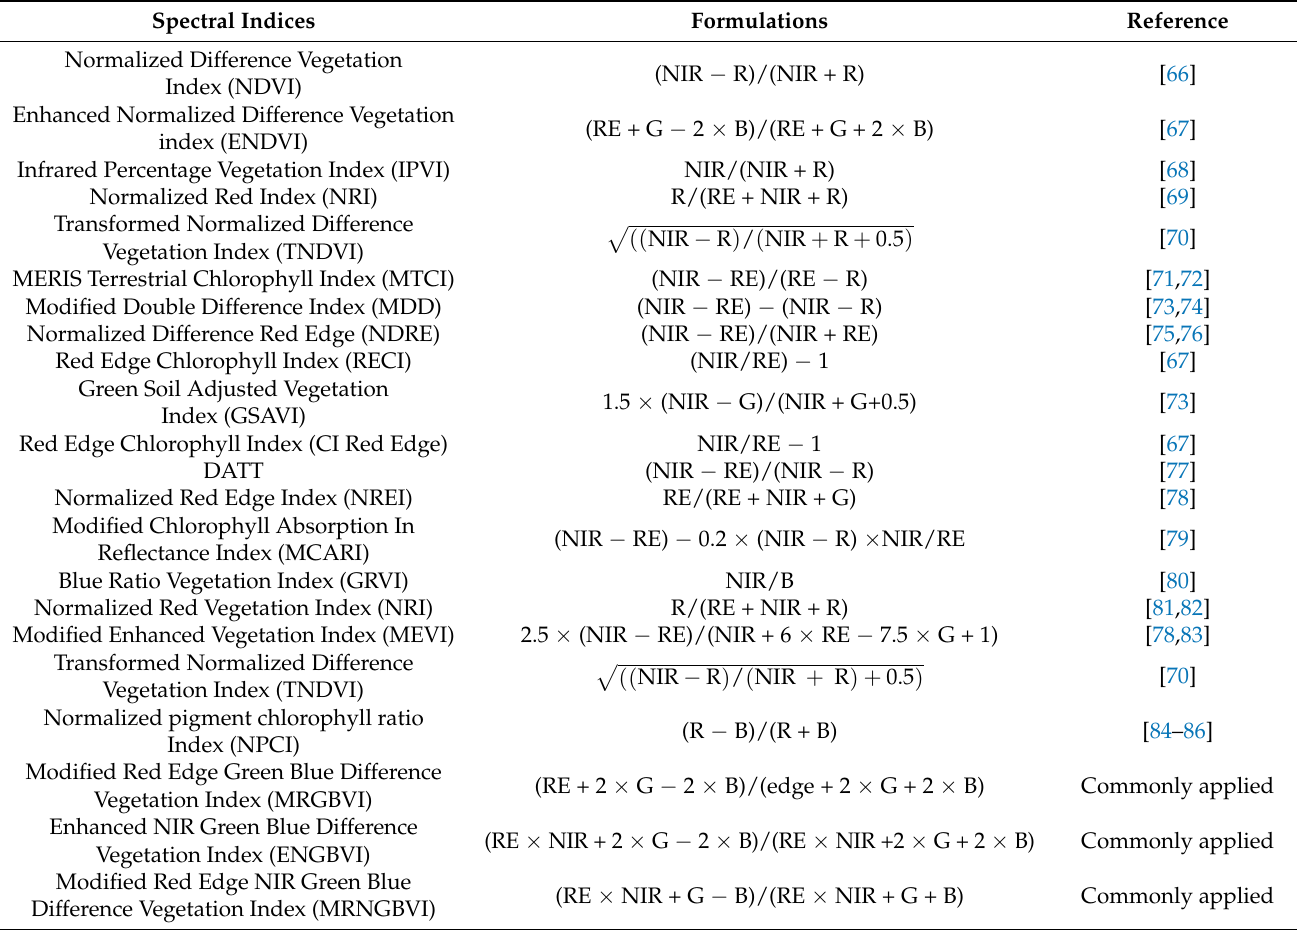
Table 2. The multi-spectral indices evaluated in this study. B, G, R, RE, and NIR each represent the blue, green, red, red edge, and near infrared band in reflectance. The first column indicates the name of spectral indices, the second column is the corresponding definition of the spectral indices, and the third column is the